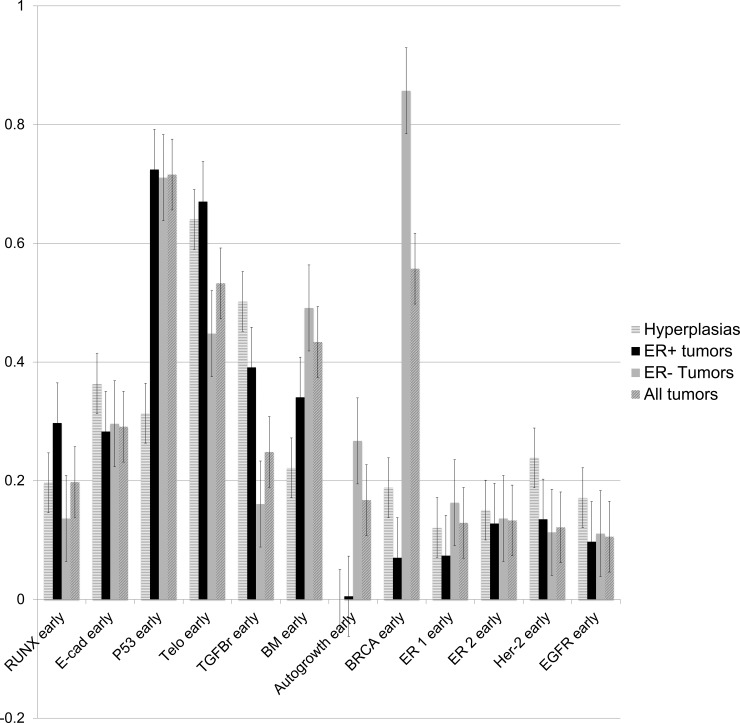
The proportion of hyperplasias, ER+ tumors, ER- tumors and a composite of all tumors bearing an “early” mutation in each of the Duct Epithelium Agent-based Model’s (DEABM) genes is represented above.The DEABM allows for the sequential tracking of mutations that have been acquired by a lineage of cells and a mutation was defined as “early” if it occurred as one of the first five mutations acquired. By unpaired, two-tailed T-test ER+ tumors accumulated more early mutations in genes leading to impaired apoptosis (telomerase, p < .01) and proliferation in response to estrogen (RUNX3, TGFB-r, p < .01). ER- tumors accumulated more early mutations in genes associated with genomic instability (BRCA1, p < .01), epithelial-mesenchymal transition (MMP-3, p < .01), and hormone-independent growth (c-MYC, p < .01). Early P53 mutations were common to all tumors. Hyperplastic populations were significantly more likely to acquire early mutations to telomerase, TGFB-r and E-cadherin, genes predisposing to failure of apoptosis and proliferation of ER+ cells without invasive behavior.